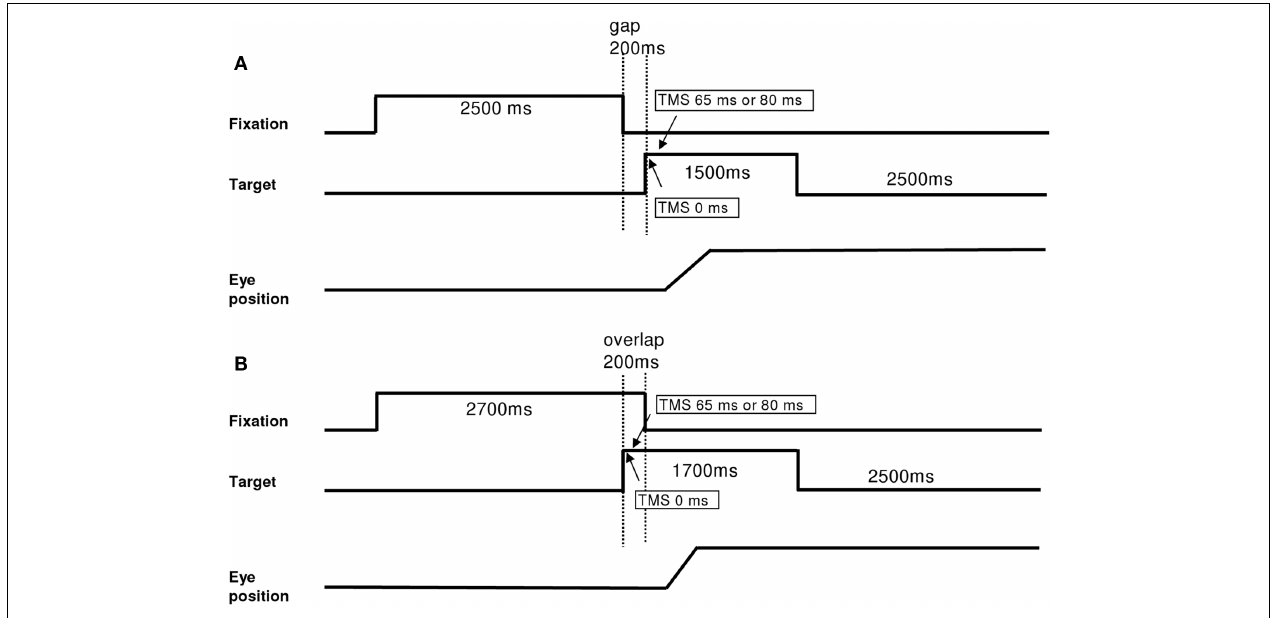
FIGURE 1 | Experimental tasks: gap (A) and overlap (B). Latency started when the target appeared. For blocks with dTMS, the first stimulation was done with the onset of the target (0ms) and the second stimulation 65 or 80ms after, in both tasks.